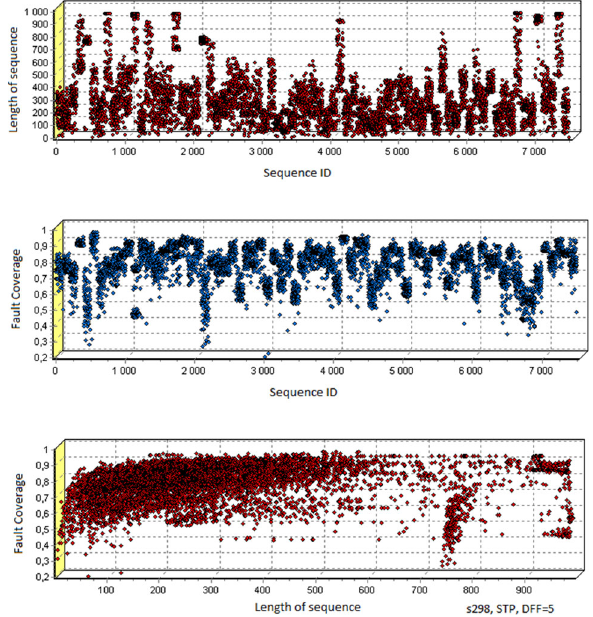
Fig. 26 STP for s298 with use of 5 internal flip-flops